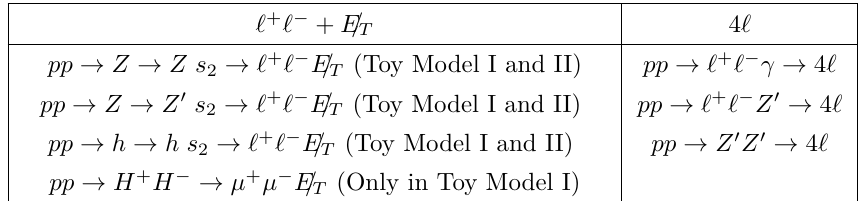
Table 5 . Collider signatures resulting in dilepton and 4-lepton final states for both toy models. Sl.No.